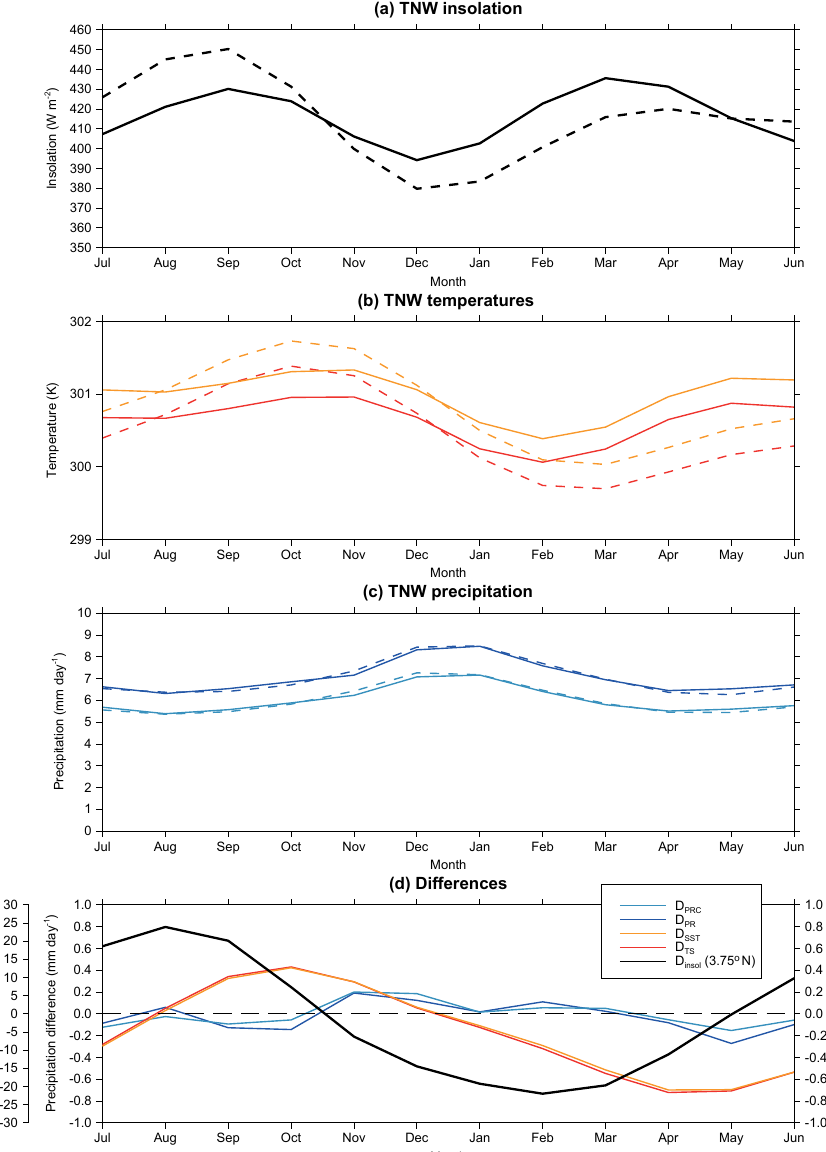
Figure 5. The monthly, ensemble and regional mean (a) insolation (taken at 3.75 ◦ N for insolation, black line, Wm − 2 ), (b) surface temper- ature (land and ocean combined, red line, K) and sea surface temperature (when available, amber line, K) and (c) total precipitation (blue line, mmday − 1 ) and convective precipitation (turquoise line, mmday − 1 ) at 0ka (solid lines) and 6ka (dashed lines) within the TNW box. The difference in those fields (insolation, temperature and precipitation) for 6 − 0ka is plotted in (d) .